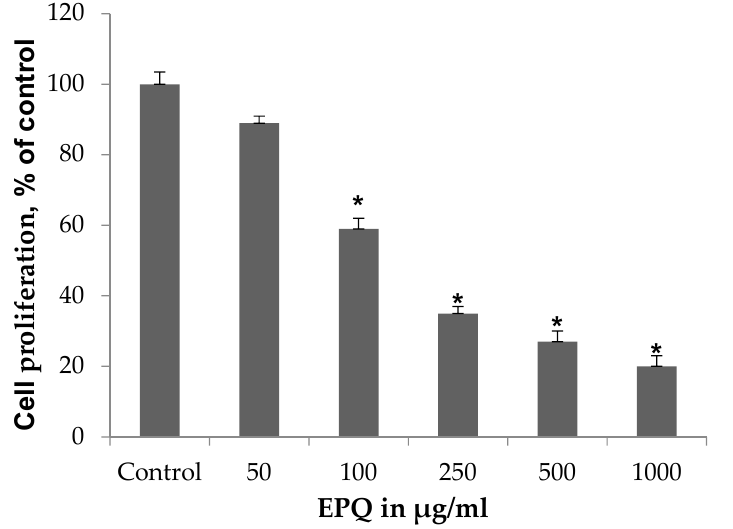
Figure 6. Effect of EPQ on viability of A-2780 cells: MTT 24 h (* indicates significance of at least ( p ≤ 0.0001) with respect to control). Control solvent is phosphate buffered saline (PBS).